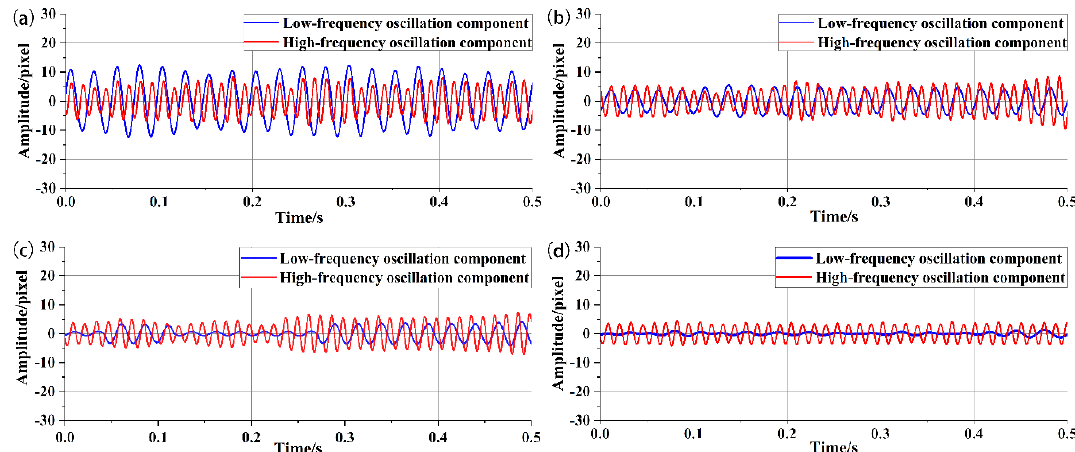
Figure 12. Components of the weld pool oscillation signal at 40 Hz and 80 Hz with different penetration status. Full penetration: ( a ) V = 11 cm/min; ( b ) V = 16.5 cm/min. Critical penetration: ( c ) V = 19.25 cm/min. partial penetration: ( d ) V = 30.25 cm/min.